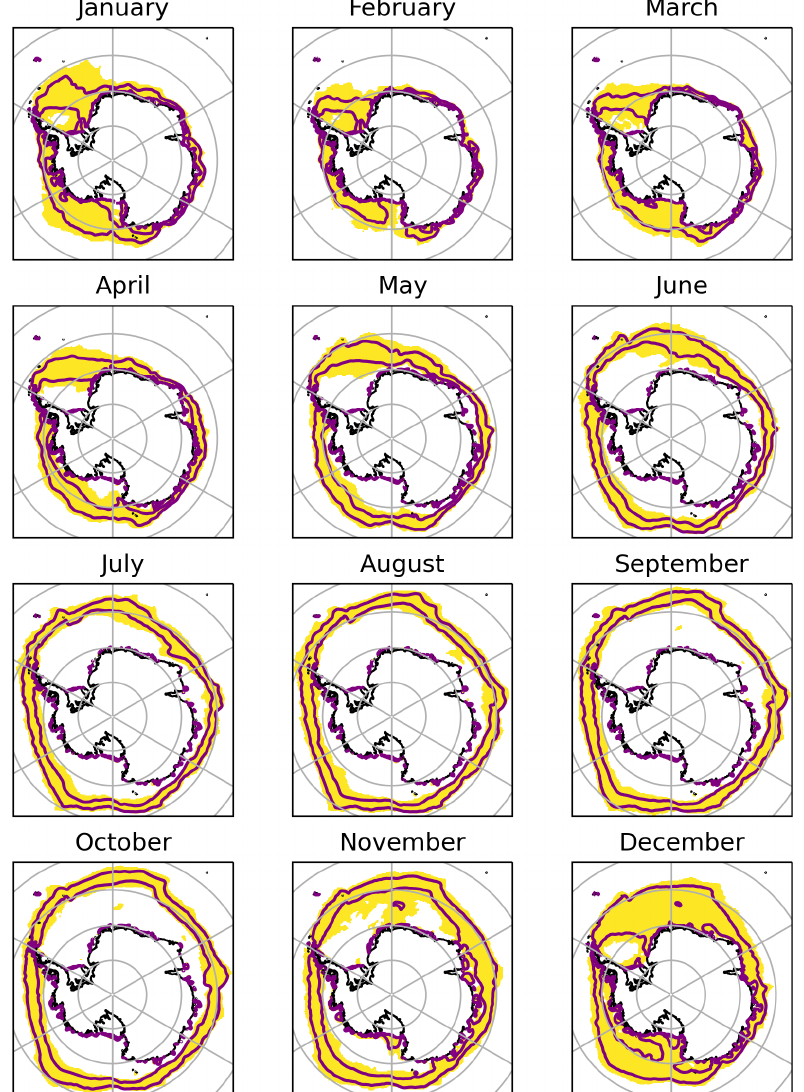
Figure 10. Climatological monthly mask of the MIZ obtained from the σ n using the SIC